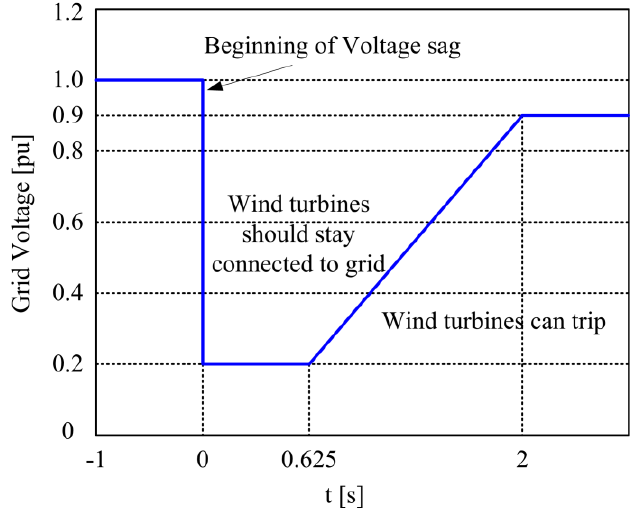
Figure 2. The LVRT (low voltage ride-through) requirements in